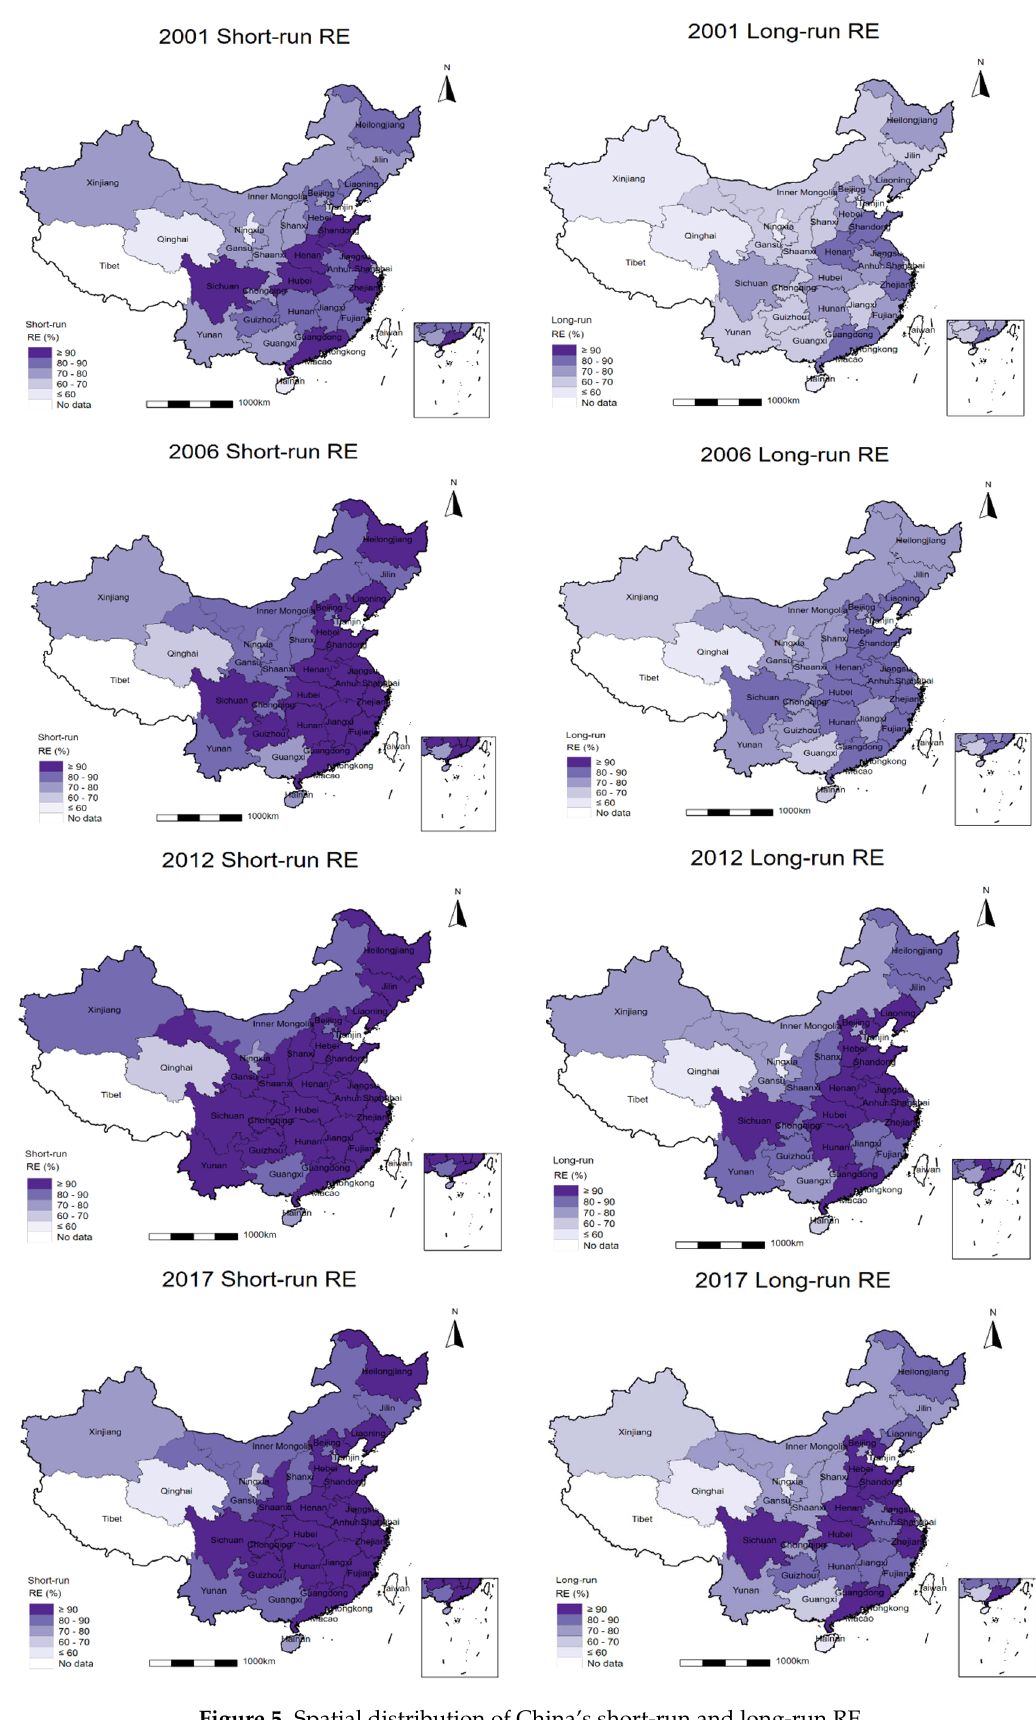
Figure 5. Spatial distribution of China’s short-run and long-run